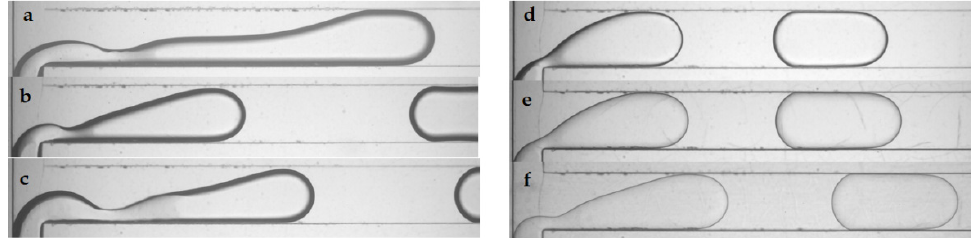
Figure 9 . Slug formation of Newtonian and non-Newtonian dispersed phases: ( a ) XG, ( b ) CMC 0.5%, ( c ) CMC 1.5%, ( d ) G1, ( e ) G2, and ( f ) G3.